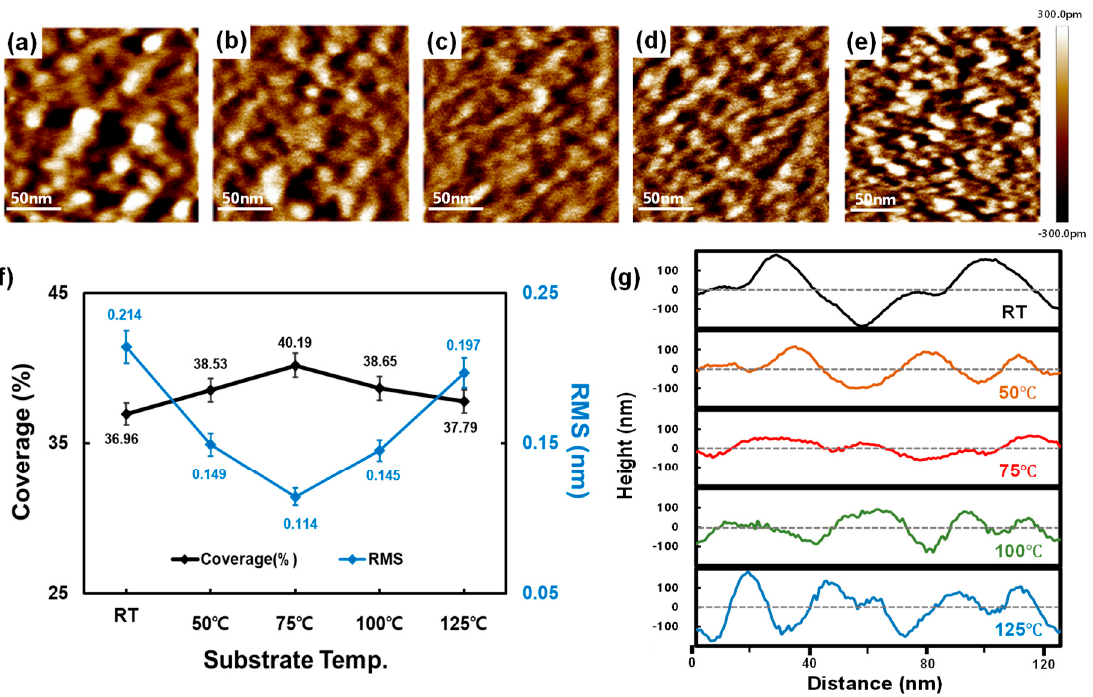
Figure 5. AFM image of V 2 O 5 − x (5 nm) TF deposited at different substrate temperatures: ( a ) RT, ( b ) 50 °C, ( c ) 75 °C, ( d ) 100 °C, and ( e ) 125 °C. ( f ) Surface coverage and roughness (RMS) and ( g ) cross-sectional profile of each deposited V 2 O 5 − x TF.